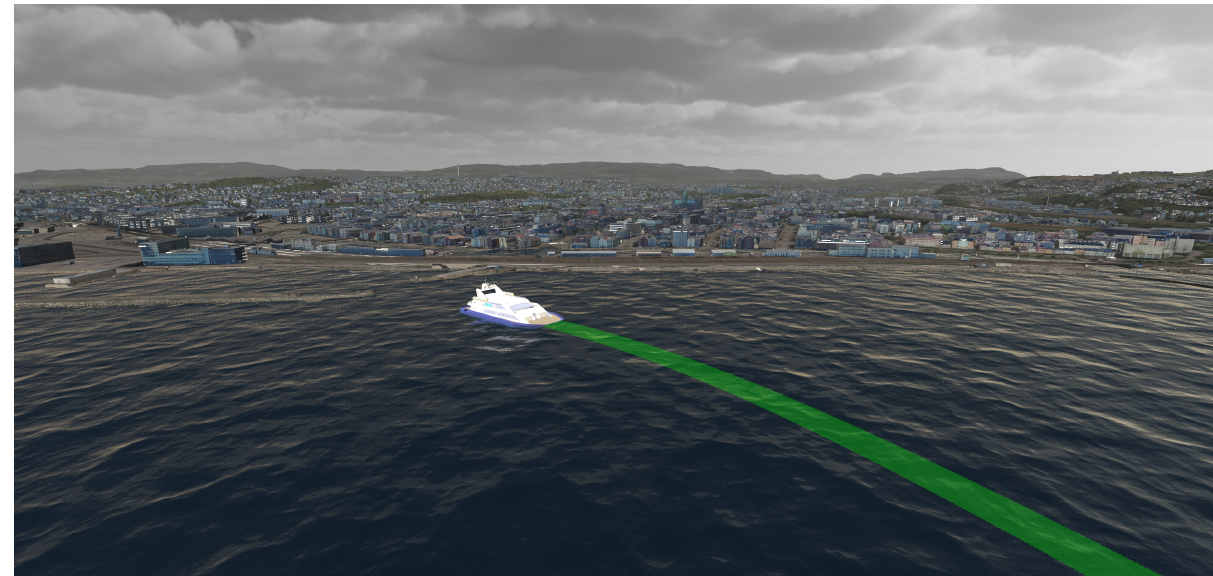
Figure 7: 3-D visualization of a catamaran passenger boat in the Trondheim fjord using the Unity game engine (Unity, 2018), and the Hydroform Ocean System and Terraland plugins from the Unity Asset Store ( http://assetstore.unity.com ). The green arrow shows the predicted path of the